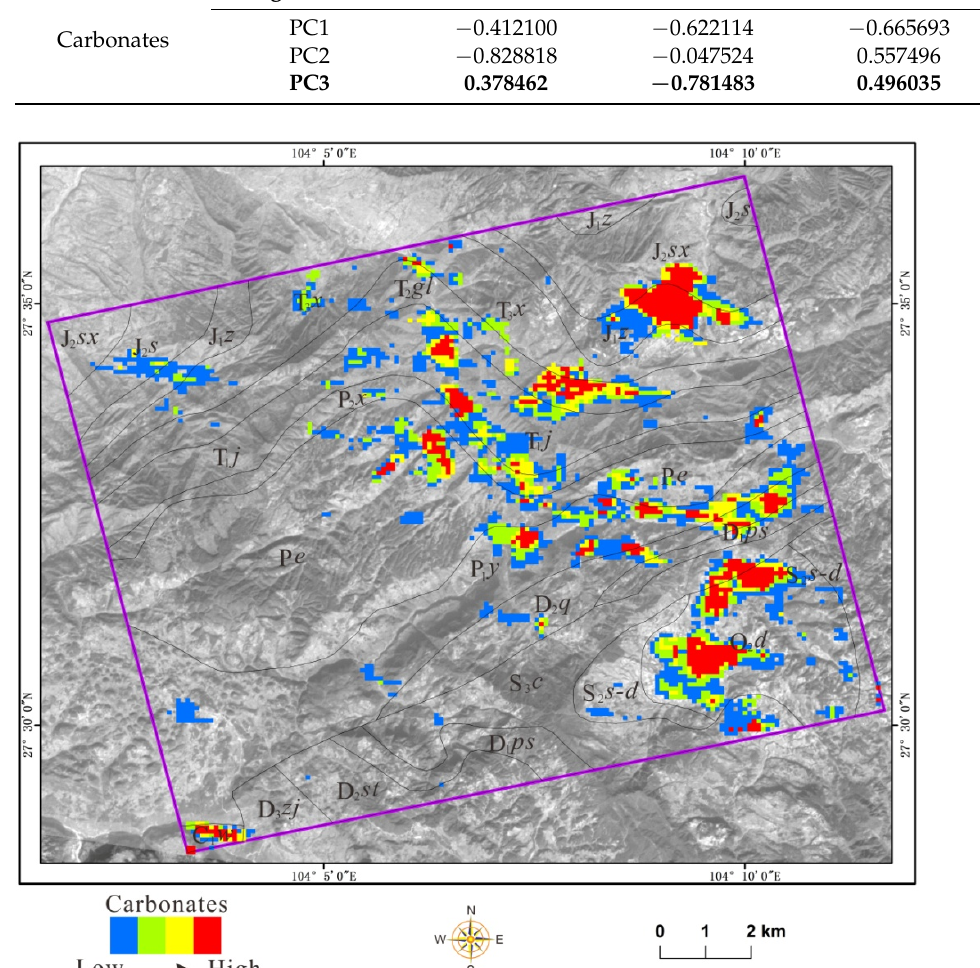
Figure 6. Carbonate minerals mapped with ASTER data using the SPCA